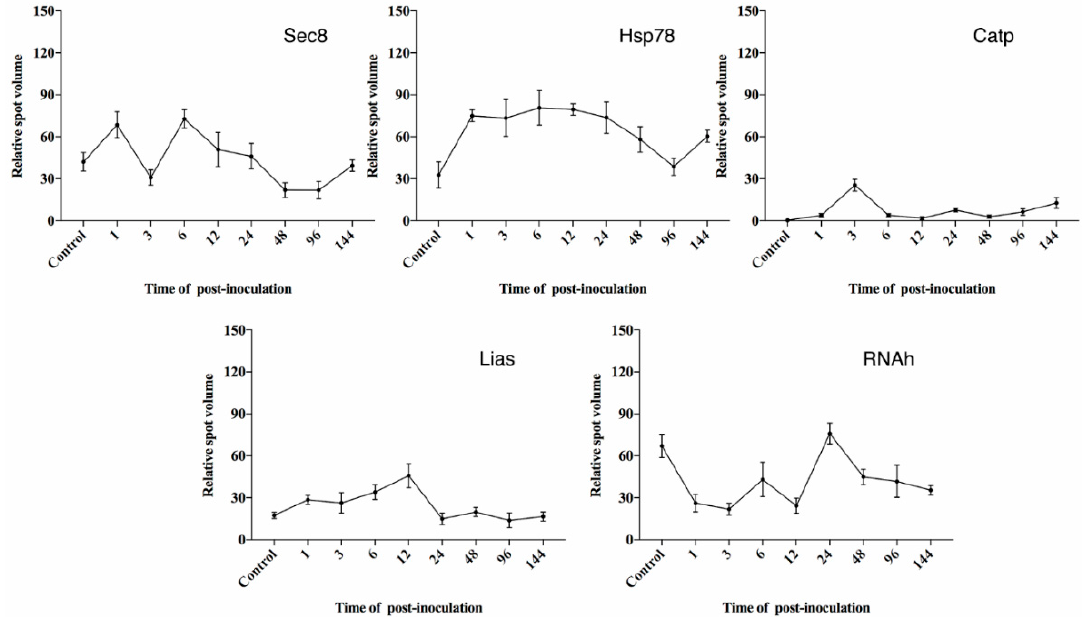
Figure 7. Protein spots of significant expression identified from Metarhizium anisopliae. X -axis: time (hours) of PI; Y -axis: mean of relative spot volume (×10 3 ).